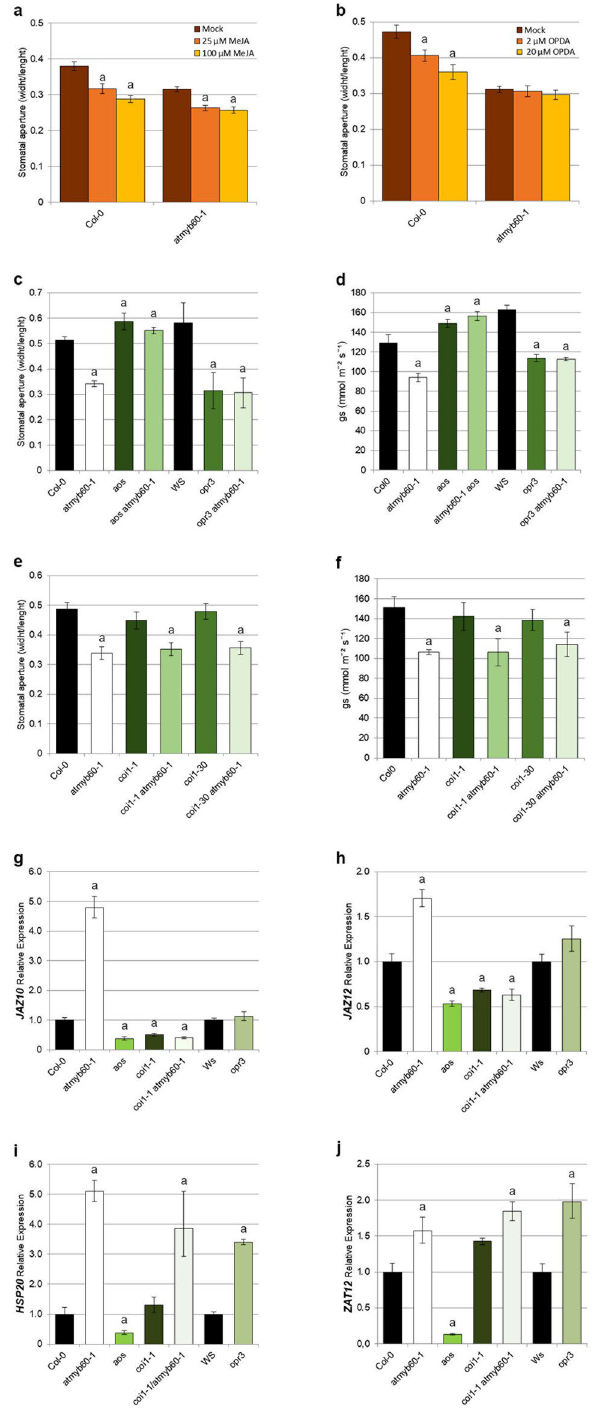
Figure 4. Defective stomatal opening in atmyb60-1 is associated with 12-OPDA accumulation in guard cells. ( a , b ), Stomatal aperture measurements in Col-0 and atmyb60-1 epidermal strips determined after 4 h of treatment with 25 or 100 μM MeJA ( a ) and with 2 or 20 μM 12-OPDA ( b ). Stomatal opening is expressed as the width/length ratio of the stomatal pore. ( c , d ) Stomatal aperture ( c ) and stomatal conductance ( g s ) ( d ) of Col-0, atmyb60-1 , aos , aos atmyb60-1 , Ws, opr3 and opr3 atmyb60- 1 plants. ( e , f ) stomatal aperture ( e ) and stomatal conductance ( f ) of Col-0, atmyb60-1, coi1-1 , coi1-1 atmyb60-1 , coi1-30 and coi1-30 atmyb60-1 leaves. Stomatal opening values represent the mean ± standard error of three separate experiments (n = 100–150 stomata per genotype per experiment). Stomatal conductance values represent the mean ± standard error of three separate experiments (n = 10 leaves per genotype per experiment). ( g – j ) qPCR analysis of JAZ10 ( g ), JAZ12 ( h ), HSP20 and ZAT12 ( j ) expression in Col-0, atmyb60-1 , aos , coi1-1 , coi1-1 atmyb60-1 , Ws and opr3 10-day-old seedlings. Relative gene expression was normalized to the expression of the AtACTIN2 gene. "a" indicates statistically significant difference between mutants and their respective wild type (Col-0 or Ws) (P < 0.01, t